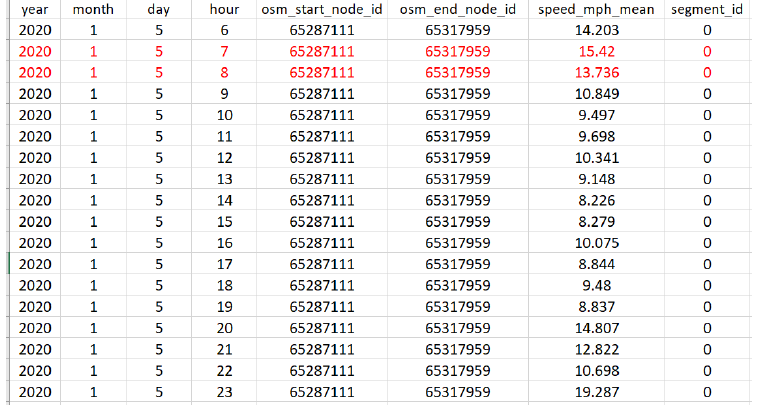
Figure 3. An illustration of the initial dataset for segment 0 (on 5 January 2020, from 6:00 to 24:00) with two missing values.